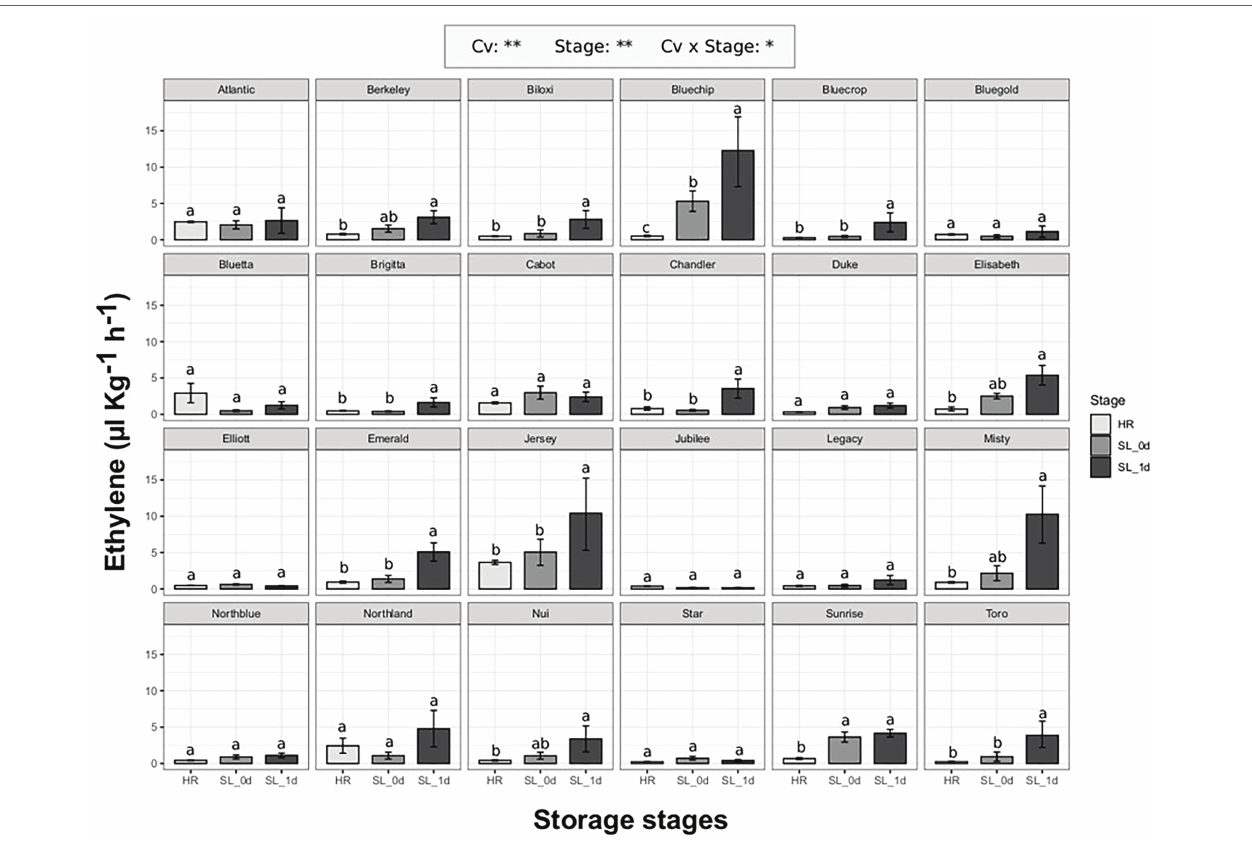
FIGURE 2 | Ethylene production rate of 24 blueberry cultivars assessed at harvest (HR), after 4 weeks of storage at 2 ° C (SL_0d), and after one additional day of shelf life at 21 ° C (SL_1d). Each measurement was done in four replicates. Ethylene measurement was assessed on intact berries by using an PTR/SRI-ToF-MS set in O 2+ mode. ANOVA levels of significance ( p < 0.05 and p < 0.01) are represented by * and ** , respectively. Different letters indicate significant differences between treatments ( p ≤ 0.05) according to Tukey ʼ s post-hoc